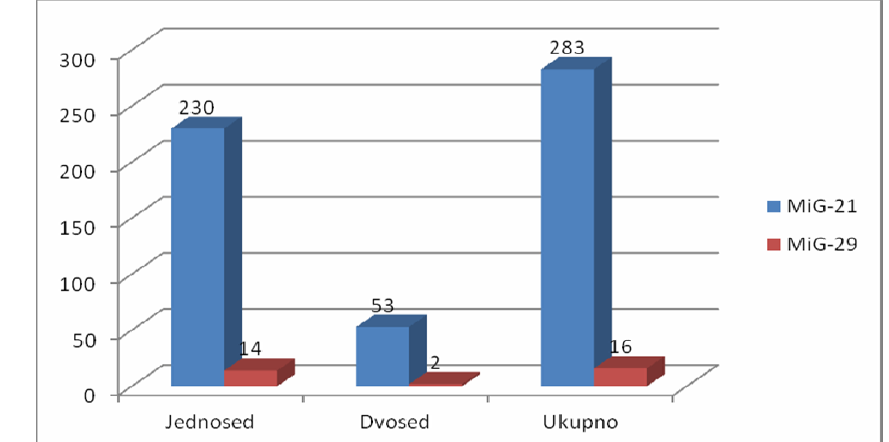
Figure 3 – Relation between one and two-seat MiG-21 and MiG-29 fighters in the national air